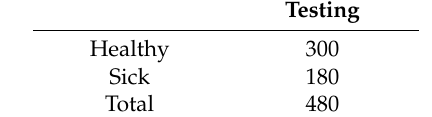
Table 4. Dataset reparation use for validation test.